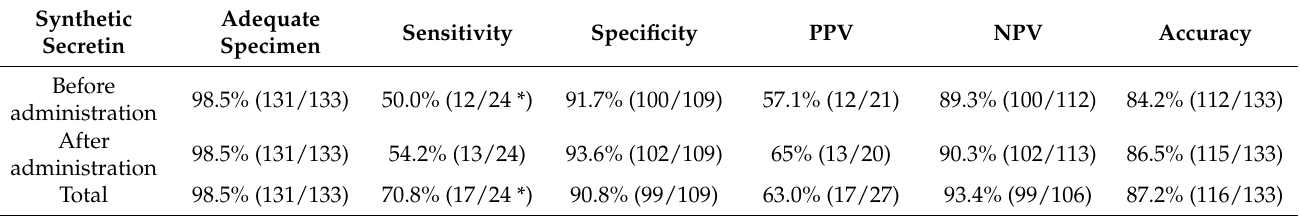
Figure 2. Comparison of cell numbers in the pancreatic juice before and after synthetic secretin administration. After synthetic secretin administration, cell clumps (red circles) were increased in both cases 1 and 2. Table 5. Diagnostic ability of pancreatic juice